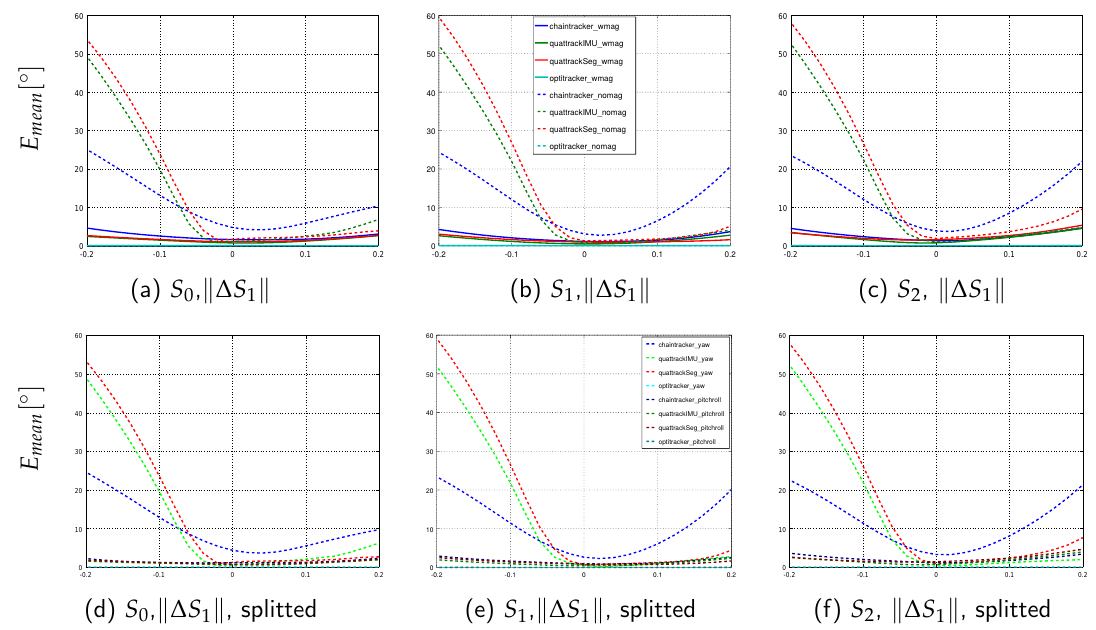
Figure 7. Simulation scenario: The upper row shows the per segment mean angular error distributions on sim-fast for segment length errors. The lower row shows the errors w/o magnetometers splitted into yaw and pitch/roll